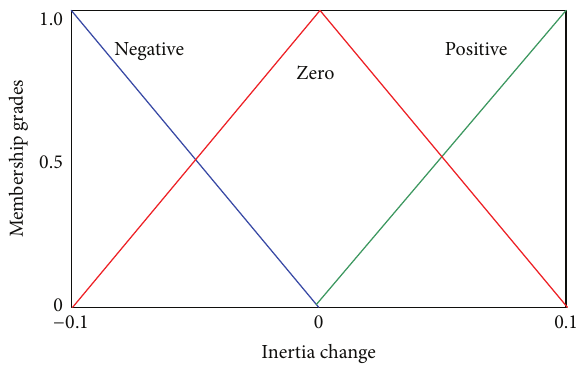
Figure 4: Membership function plots for fuzzy sets corresponding to negative , zero , and positive inertia change ( Δ𝜔